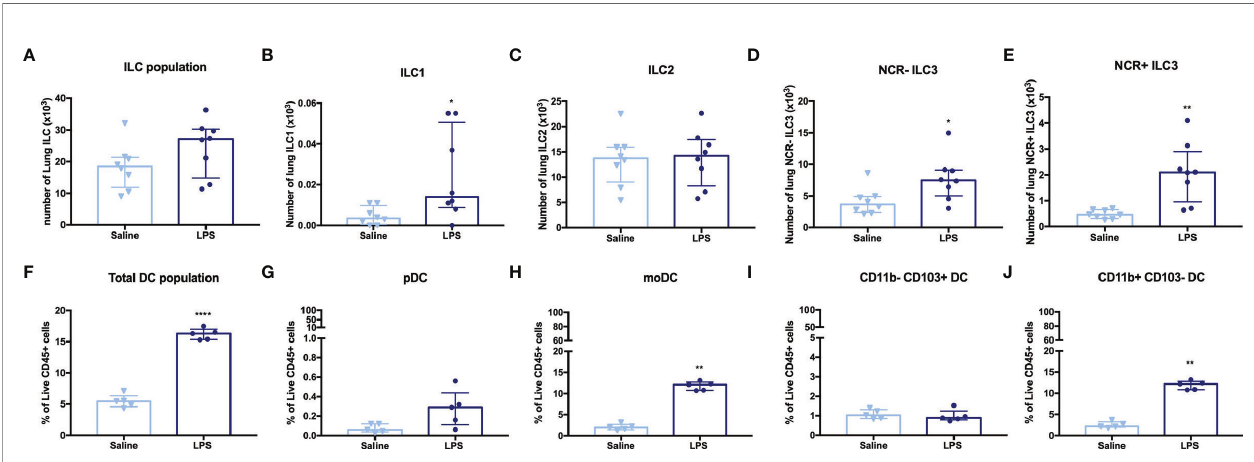
FIGURE 2 | Lung innate lymphoid cells (ILC) and dendritic cells (DC) in LPS-challenged and control mice. BALB/c mice were endonasally challenged with LPS (2 µg in 50 µl saline) or saline on four consecutive days ( Supplementary Figure 1A ). Twenty-four hours after the last challenge with LPS, lung tissue was resected for cell isolation and the different innate lymphoid cell (ILC) and dendritic cell (DC) subsets were identi fi ed by staining with mAbs and fl ow cytometric analysis. (A) ILC population (CD45 + Lin - CD90.2 + CD127 + cells). (B) ILC1 (CD45 + Lin - CD90.2 + CD127 + KLRG1 - ROR g T - NKp46 + ). (C) ILC2 (CD45 + Lin - CD90.2 + CD127 + KLRG1 + ROR g T - NKp46 - ). (D) NCR - ILC3 (CD45 + Lin - CD90.2 + CD127 + KLRG1 - ROR g T + NKp46 - ). (E) NCR + ILC3 (CD45 + Lin - CD90.2 + CD127 + KLRG1 - ROR g T + NKp46 + ). (F) DC population (CD45 + CD11c + MHCII + ). (G) pDC (CD45 + CD11c + MHCII + Siglec H + CD11b - ). (H) moDC (CD45 + CD11c + MHCII + CD64 + ). (I) CD11b - CD103 + DC (CD45 + CD11c + MHCII + CD11b - CD103 + ). (J) CD11b + CD103 - DC (CD45 + CD11c + MHCII + CD11b + CD103 - ). ILC (total and subpopulations) are shown in absolute numbers of cells recovered from one left lung lobe in saline-treated mice (n = 8) and LPS-treated (n = 8). The total DC and subpopulations are expressed as % of live CD45+ cells in saline-treated mice (n = 5) and LPS-treated mice (n = 5). All